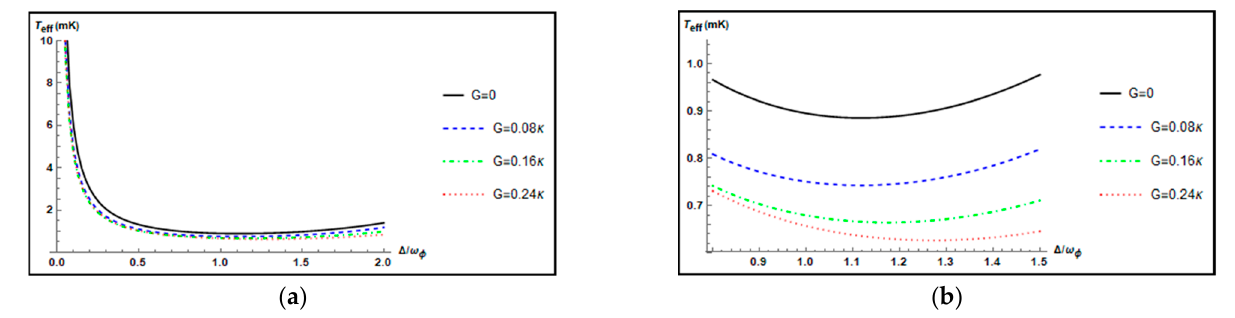
Figure 5. ( a ) Plot of the effective temperature T ef f ( K ) of the mechanical torsional pendulum versus the normalized positive cavity detuning ∆ / ω φ for different parametric gains G = 0, 0.08 κ , 0.16 κ , 0.24 κ when l = 20, T = 3 K and θ = 0. ( b ) Enlargement of the curves of Figure 5a for the range of ∆ ∈ [ 0.8, 1.5 ] ω φ